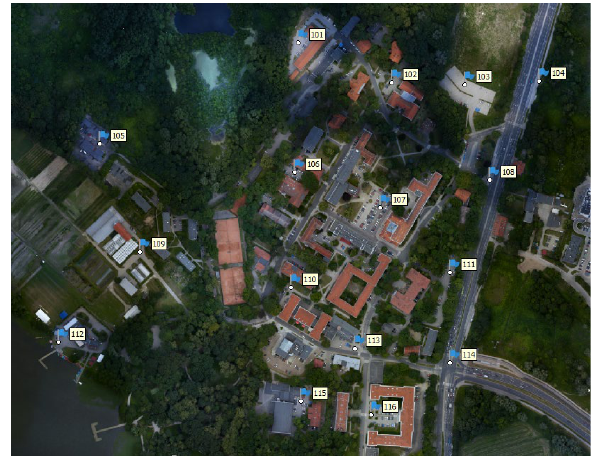
Figure 8. Visualization of a part of orthomosaic generated in